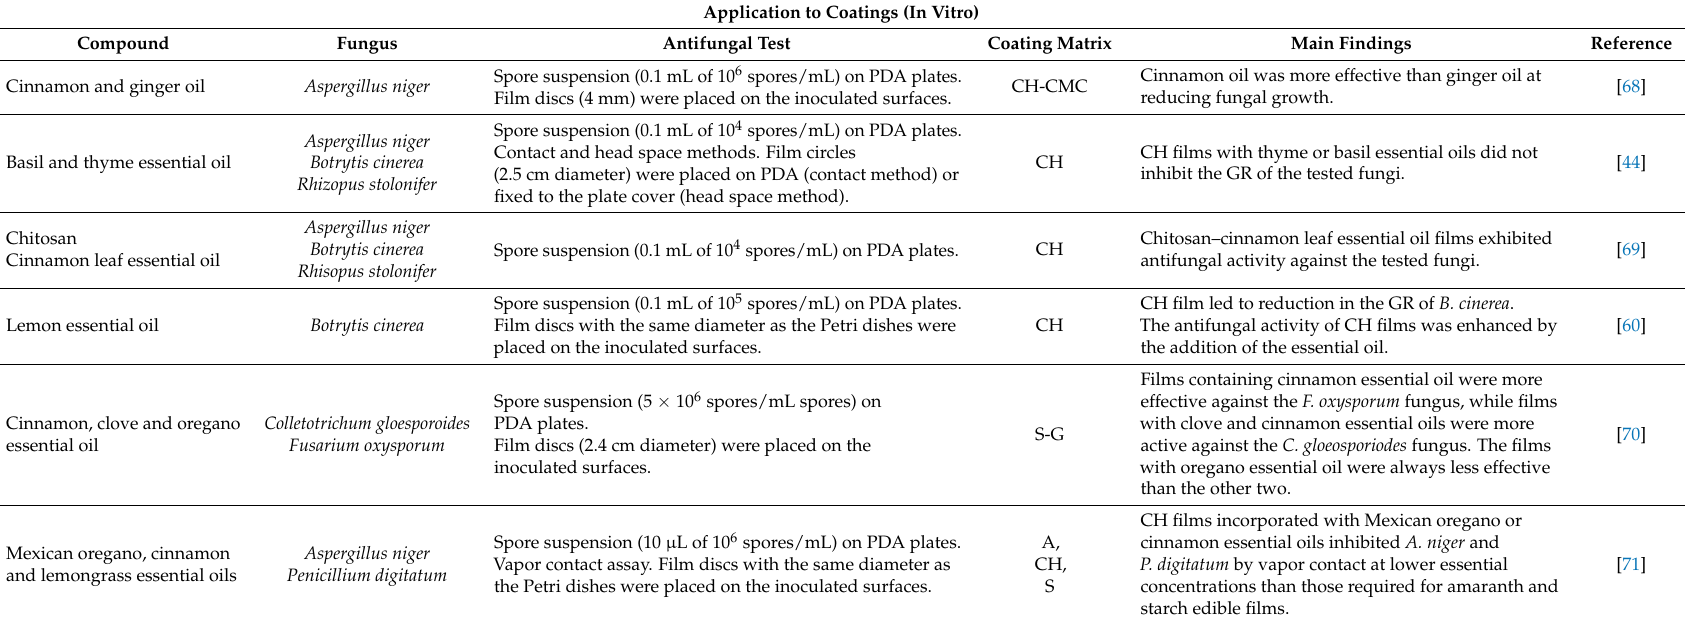
Table 5. Recent studies on natural antifungal compounds incorporated into coating-forming formulations (in vitro tests) with potential use in fruits and